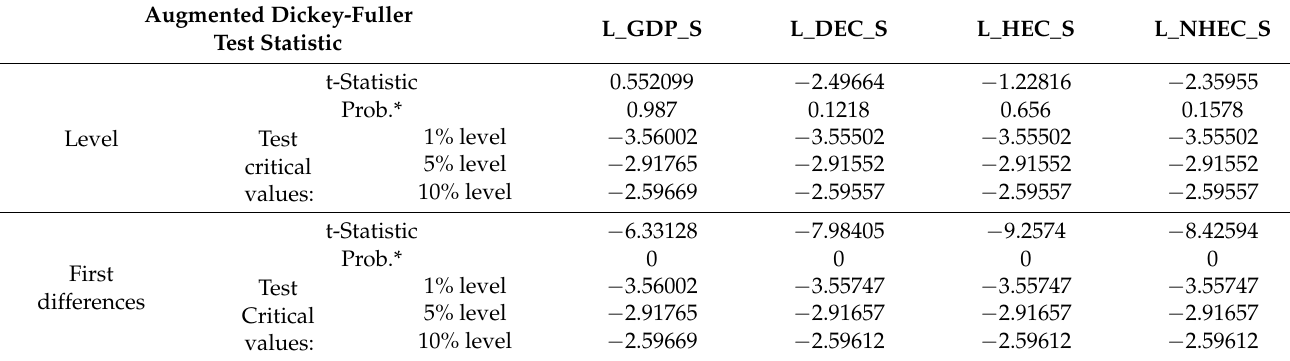
Table 3. Results of ADF unit root test.